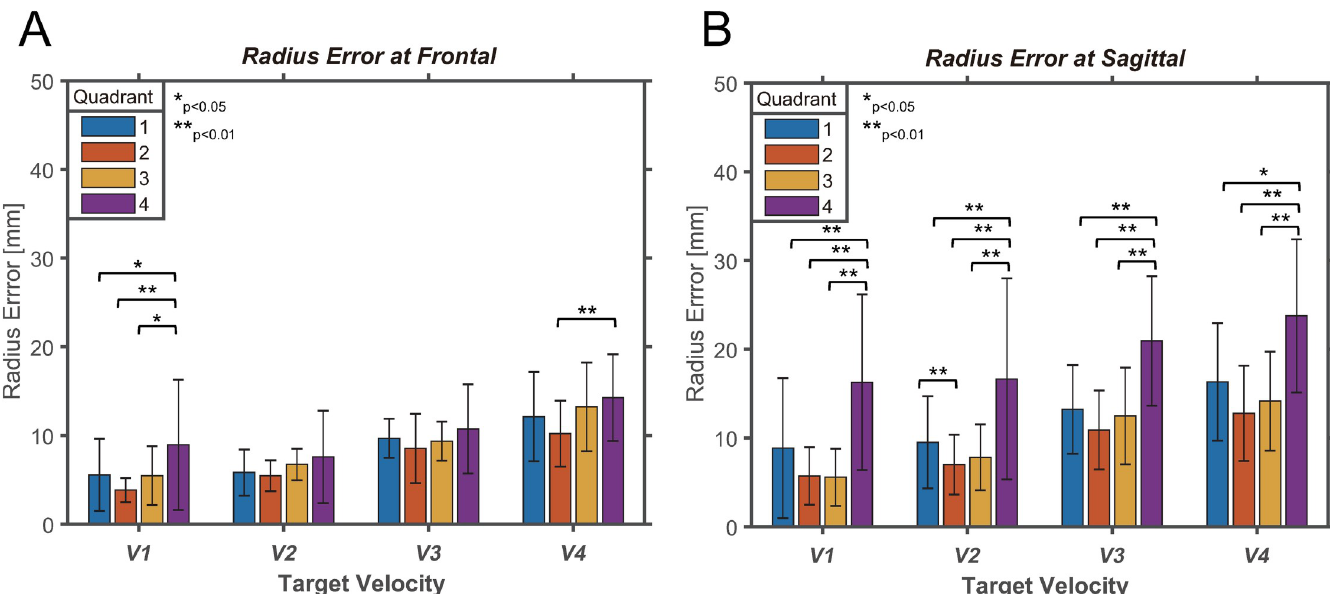
Fig 9. Evaluation of Δ R in circular tracking movement. (A) Pairwise comparisons are shown for Δ R between four quadrants on the frontal plane. (B) Pairwise comparisons are indicated for Δ R between four quadrants on the sagittal plane.